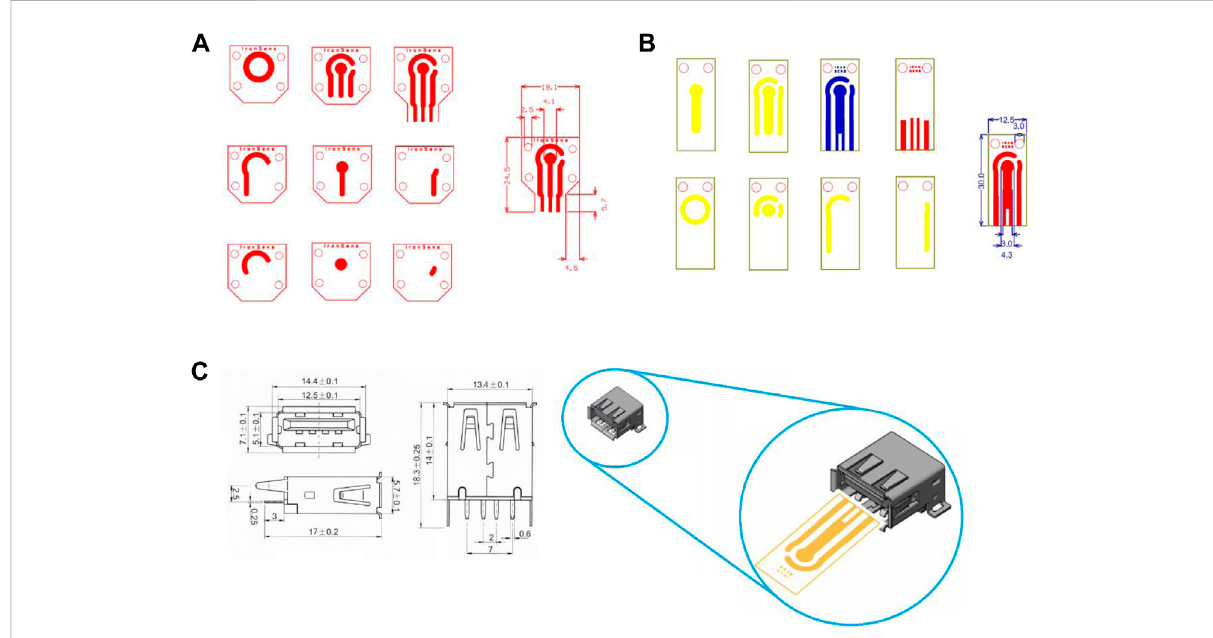
FIGURE 1 Screen printed electrode design (A) based on the port of PalmSens devices, (B) based on a standard USB port, (C) compatibility with USB port and dimension of USB